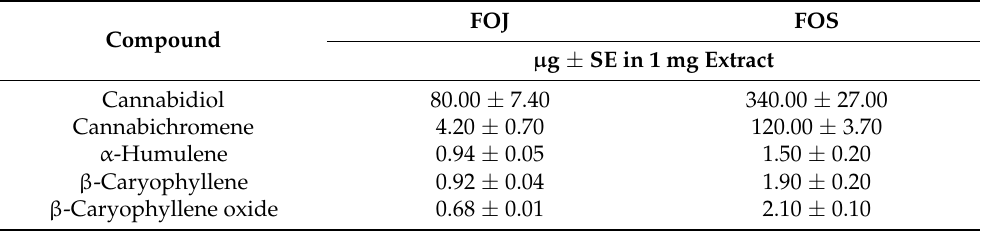
Table 1. Absolute concentration of nonintoxicating phytocannabinoids and caryophyllane sesquiter- penes in FOJ and FOS extracts from the inflorescences of Cannabis sativa var. Felina 32 collected in June and September, respectively. Data are expressed as µ g ± SE per mg of extract ( n =